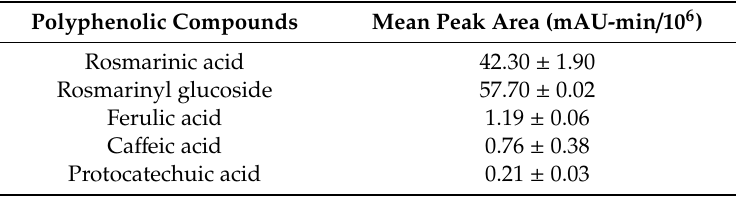
Table 3. Polyphenol profile present in chia flour.